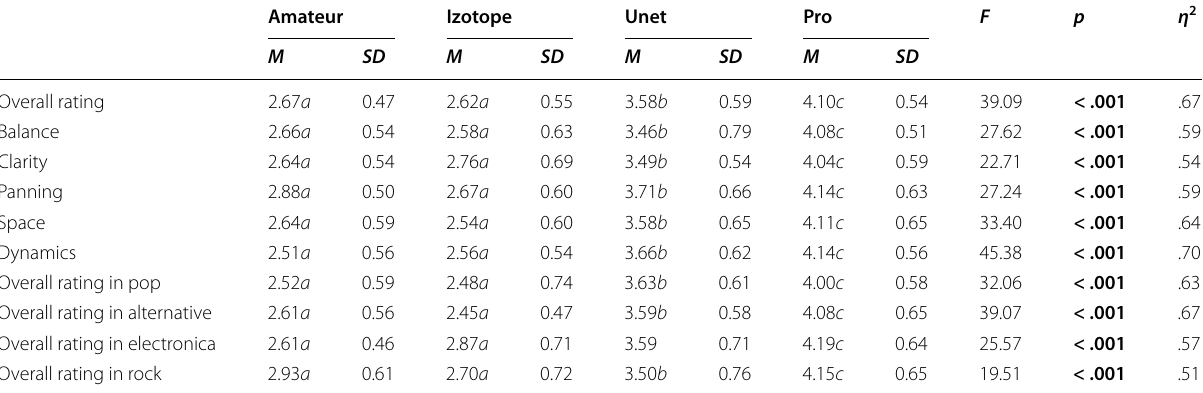
Table 4 The overall rating of the mix as a function of the mix type ( M , mean; SD , standard deviation; p p value; F , F ratio; η 2 , a measure of the effect size) indicating groups forming separate homogeneous subsets (denoted by a, b, and c)